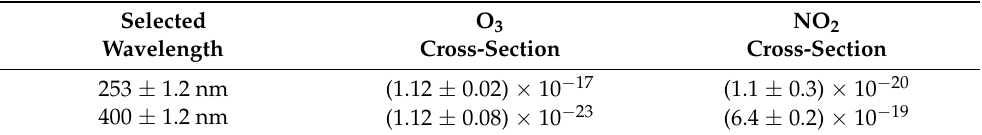
Table 2. Absorption cross-sections in cm 2 of the species of interest at each selected wavelength. Selected